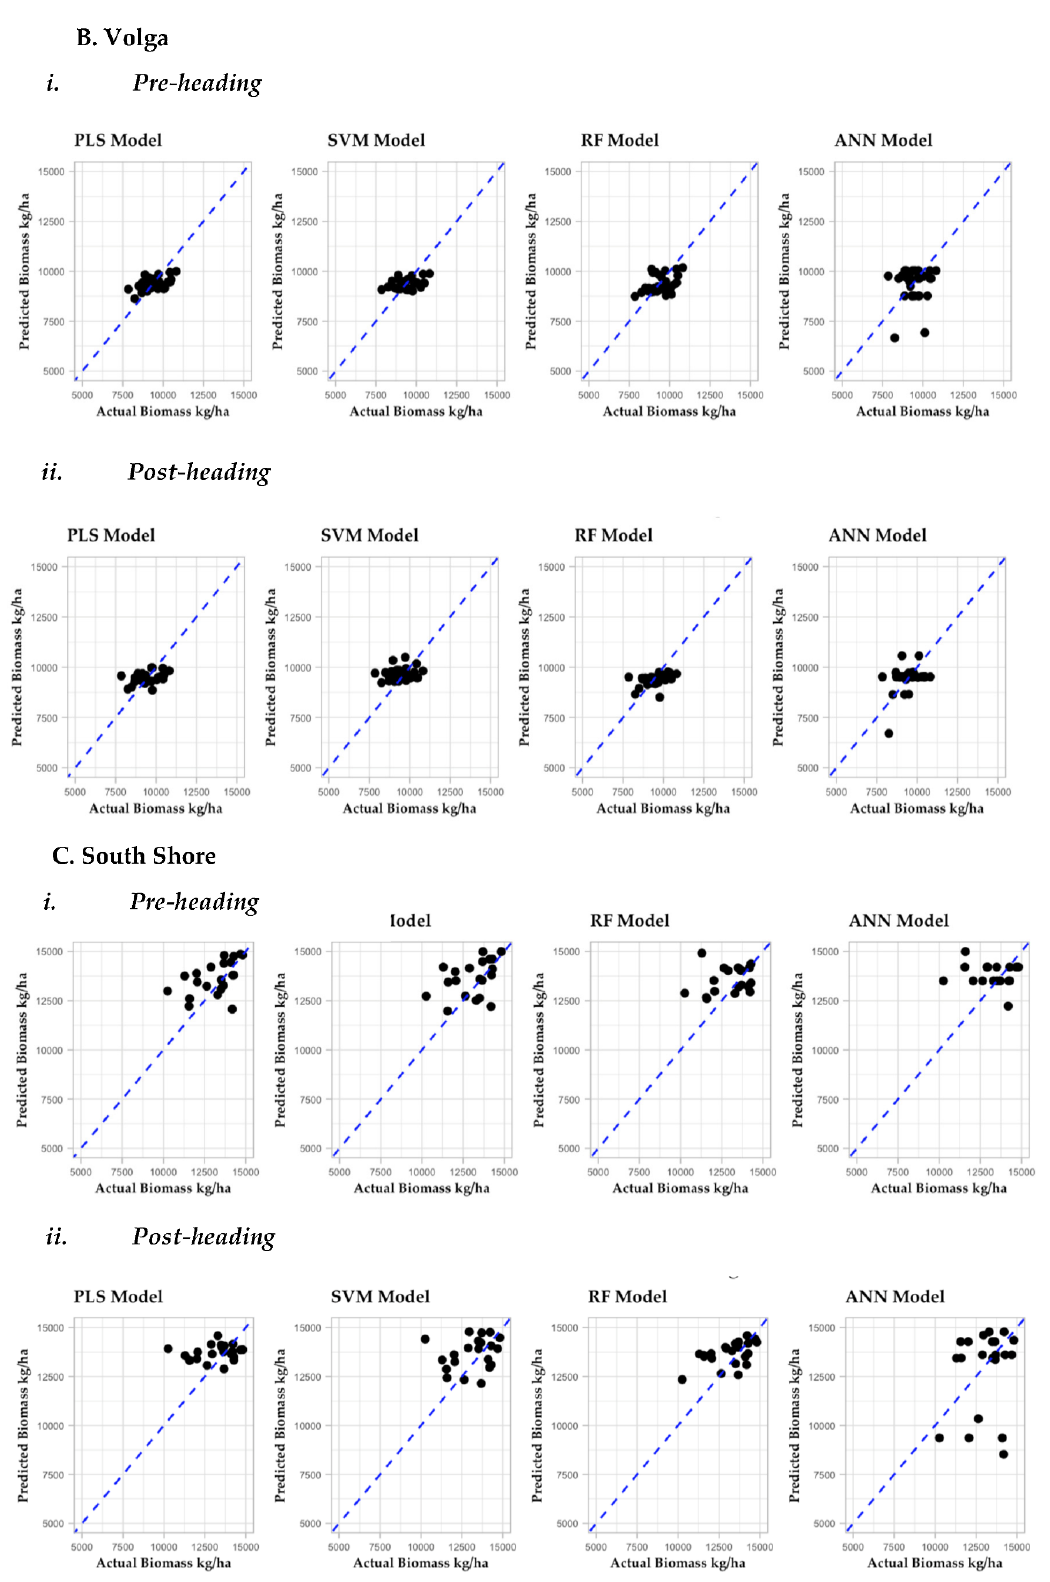
Figure 8. Plots of Predicted Vs Actual biomass yield for 35 oat genotypes grown in Beresford ( A ), Volga ( B ), and South Shore ( C ) for pre-heading ( i ) and post-heading ( ii ) phase. The horizontal axis represents the predicted biomass yield obtained from the model, and the vertical axis represents the biomass measured manually at ground